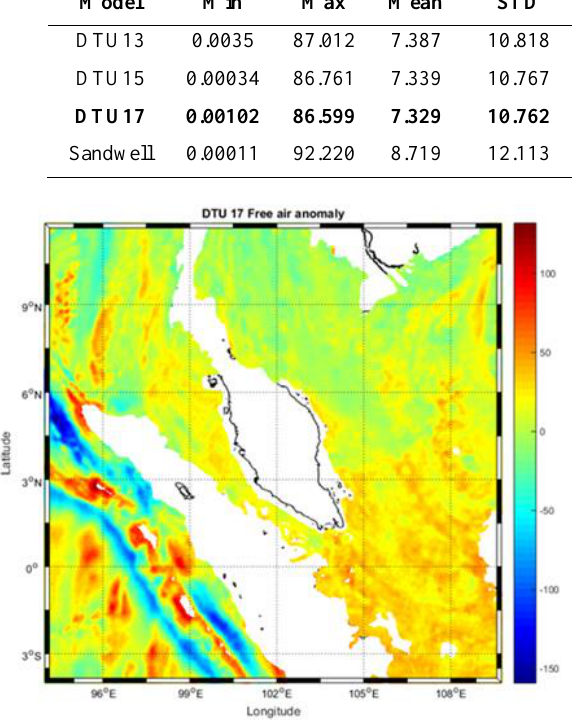
Figure 2 Free air anomaly from DTU 17